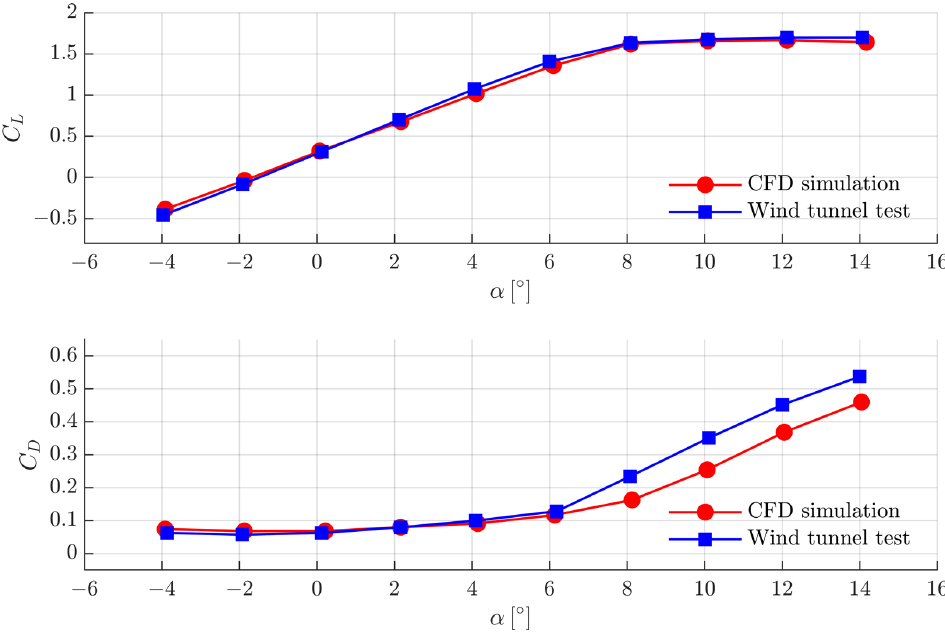
Figure 23. The results comparison of CFD simulation and experiment.